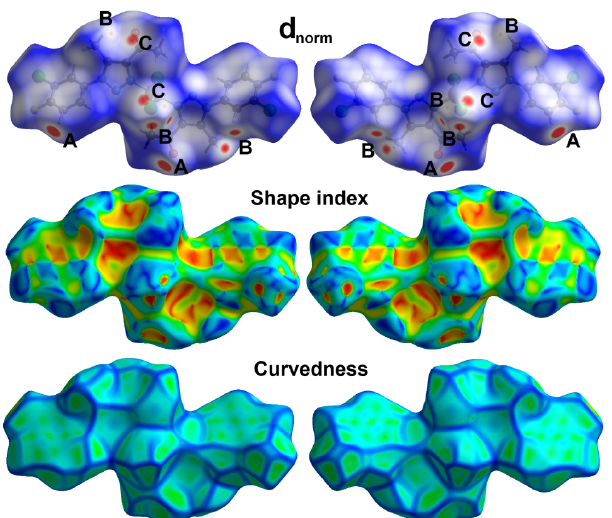
Figure 10. Hirshfeld surfaces of Pd(II) complex 4 ; A (O…H), B (Cl…H), and C (Cl…C).